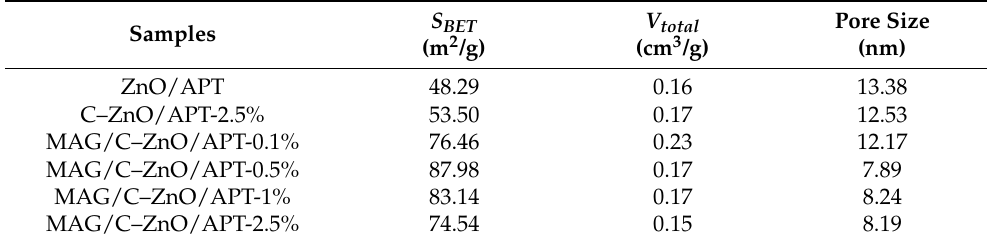
Table 1. Pore structural parameters of ZnO/APT, C–ZnO/APT-2.5% and MAG/C–ZnO/APT